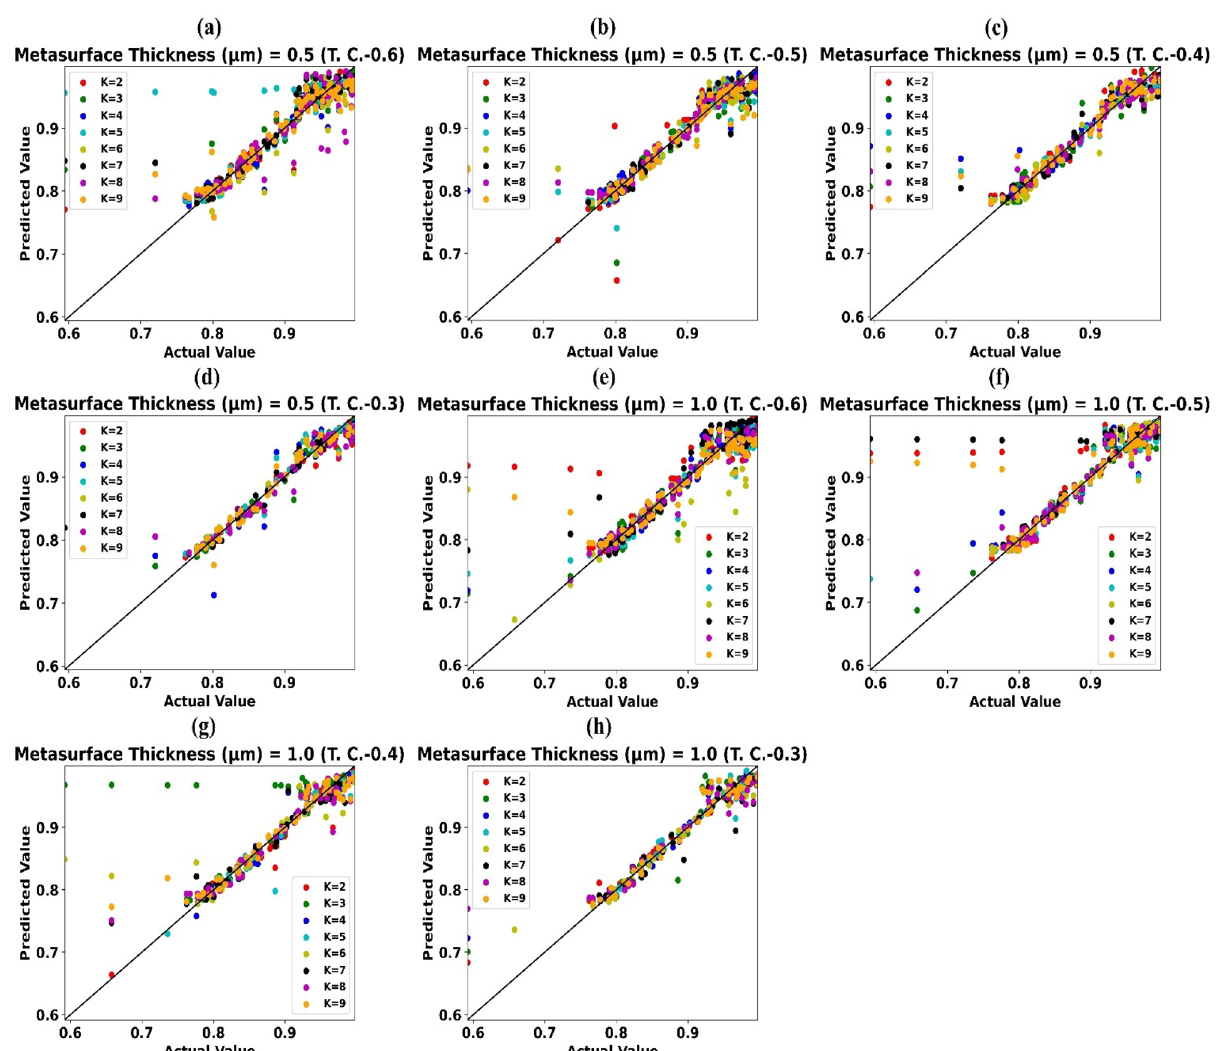
Figure 5. Predicted values of absorption by trained weighted KNN-regressor vs simulated/actual values of absorption for Metasurface Thickness (µm) ( a ) 0.5 (TC-0.6), ( b ) 0.5 (TC-0.5), ( c ) 0.5 (TC-0.4), ( d ) 0.5 (TC-0.3), ( e ) 1.0 (TC-0.6), ( f ) 1.0 (TC-0.5), ( g ) 1.0 (TC-0.4), ( h ) 1.0 Scattergrams of estimated values of absorption by trained weighted KNN-regressor model vs simulated/ actual values of absorption accomplished at the time of simulation for metasurface width 1.9 µm, 2.0 µm and Test-0.6, Test-0.5, Test-0.4, Test-0.3 are revealed in Supplementary Fig. S11a–h subsequently. Scattergrams of estimated values of absorption by trained weighted KNN-regressor model vs simulated/actual values of absorp- tion accomplished at the time of simulation for metasurface width 2.1 µm, 2.2 µm and Test-0.6, Test-0.5, Test-0.4, Test-0.3 are revealed in Supplementary Fig. S12a–h subsequently. Scattergrams of estimated values of absorption by trained weighted KNN-regressor model vs simulated/actual values of absorption accomplished at the time of simulation for metasurface width 2.3 µm, 2.4 µm and Test-0.6, Test-0.5, Test-0.4, Test-0.3 are revealed in Sup- plementary Fig. S13a–h subsequently. Scattergrams of estimated values of absorption by trained weighted KNN-regressor model vs simulated/ actual values of absorption accomplished at the time of simulation for metasurface length 1.9 µm, 2.0 µm and Test-0.6, Test-0.5, Test-0.4, Test-0.3 are revealed in Supplementary Fig. S14a–h subsequently. Scattergrams of estimated values of absorption by trained weighted KNN-regressor model vs simulated/actual values of absorp- tion accomplished at the time of simulation for metasurface length 2.1 µm, 2.2 µm and Test-0.6, Test-0.5, Test-0.4, Test-0.3 are revealed in Supplementary Fig. S15a–h subsequently. Scattergrams of estimated values of absorption by trained weighted KNN-regressor model vs simulated/actual values of absorption accomplished at the time of simulation for metasurface length 2.3 µm, 2.4 µm and Test-0.6, Test-0.5, Test-0.4, Test-0.3 are revealed in Supplementary Fig. S16a–h subsequently. Regression analysis for predicting the values of absorption of forthcoming wavelengths. The layer structure of neural network-based LSTM forecasting model is shown in Supplementary Fig. S17. It contains